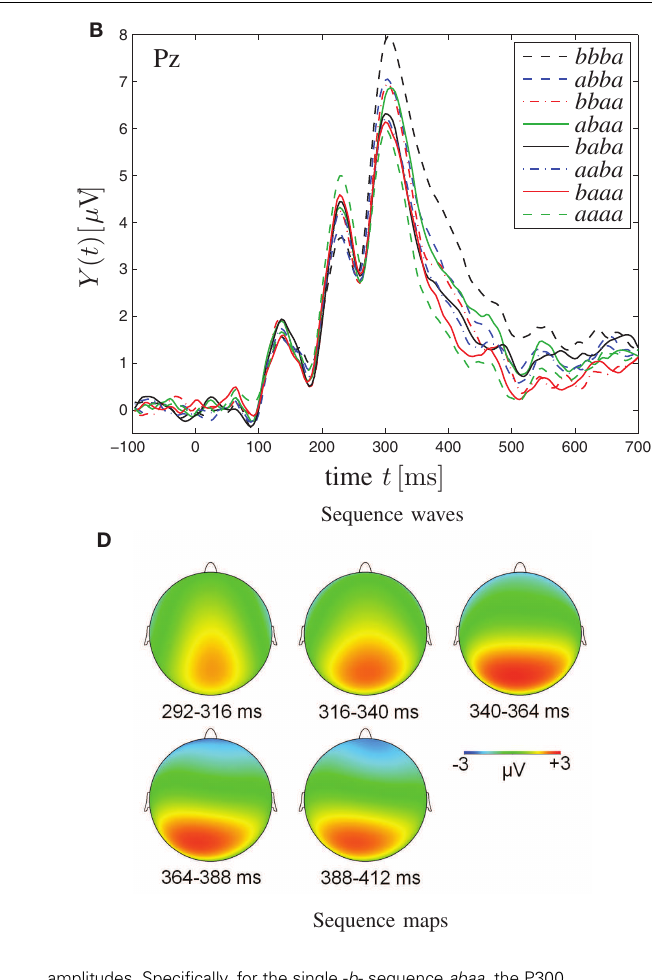
FIGURE 5 | Grand-average waveforms (A,B) and topographic maps (C,D) of P300 amplitudes. (A,C) Probability effect on P300 amplitudes in the [0.3, 0.7] probability category. (C) The probability maps show the scalp topography of the rare-frequent difference wave in the [0.3, 0.7] probability category at various points in time (276–396ms, divided into five windows of 24ms each). (B,D) Sequence effect on P300 amplitudes in the [0.5, 0.5] probability category. Note that sequences of four successive stimuli are illustrated; a signifies a particular stimulus ( b the other one). Note further that the two solid traces, originating from the abaa and the baba sequences, respectively, show reversed P300